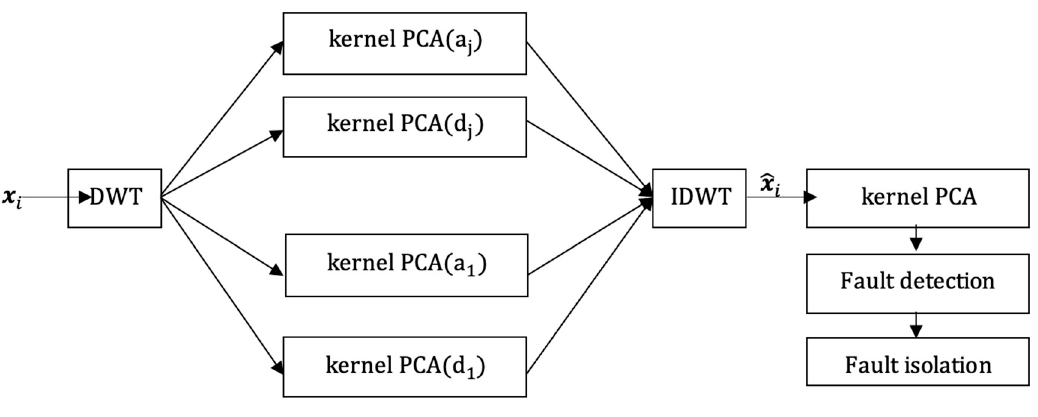
Figure 2. Multiscale kernel PCA: x i are the original data, ˆ x i are the reconstructed data, and IDWT is the inverse of DWT.